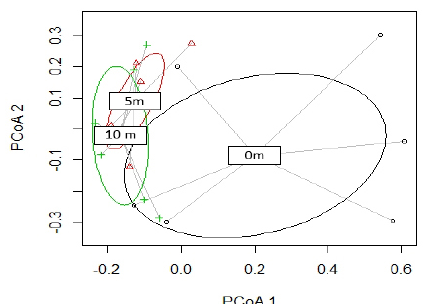
Figure 5. Principal coordinate analysis (PCoA) ordination plot with the dissimilarity in arthropods communities according to their distance from the seepage. Table 3. Results of similarity percentages (SIMPER) analysis. Most influential arthropod groups are shown, accounting for a cumulative dissimilarity between distances from the seepages of 70%. Overall (%): average contrast dissimilarity; Ratio: average contribution to overall dissimilarity to sd ratio; Cum. (%): ordered cumulative contribution of each arthropod group. Contrasts between Distances Overall % Most Influential Groups Ratio Cum. %